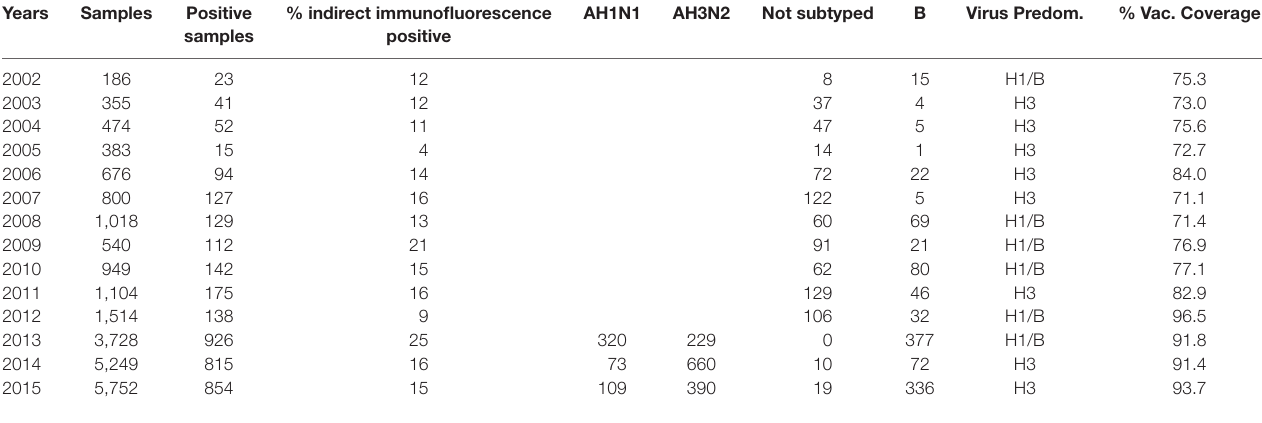
TaBle 1 | Specimens collected, positive proportion, and predominant subtypes of influenza between 2002 and 2016 in the sentinel units of southern Brazil. Years